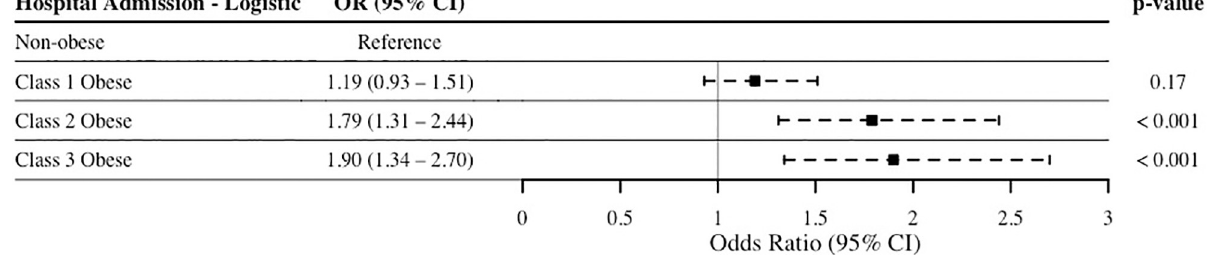
Fig 4. Unadjusted multivariable logistic regression of all-cause hospital admission. Outcome regressed on obesity categories, with non-obese (BMI < 30 kg/m 2 ) used as the reference group. Abbreviations: OR, odds ratio; CI, confidence interval.